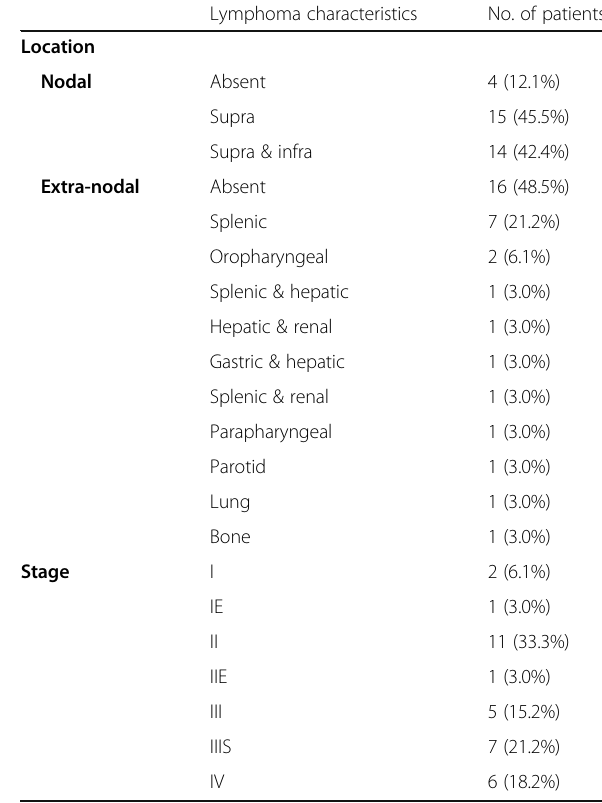
Table 3 Baseline tumor characteristics in the study